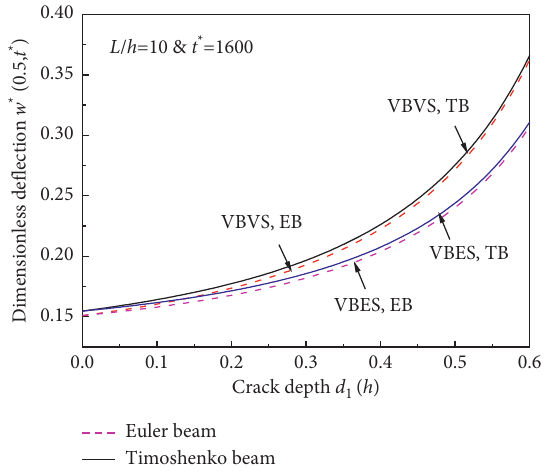
Figure 10: Response of dimensionless midspan deflection w ∗ (0.5, t ∗ ) versus crack depth d 1 / h of viscoelastic Timoshenko and Euler cracked beams.